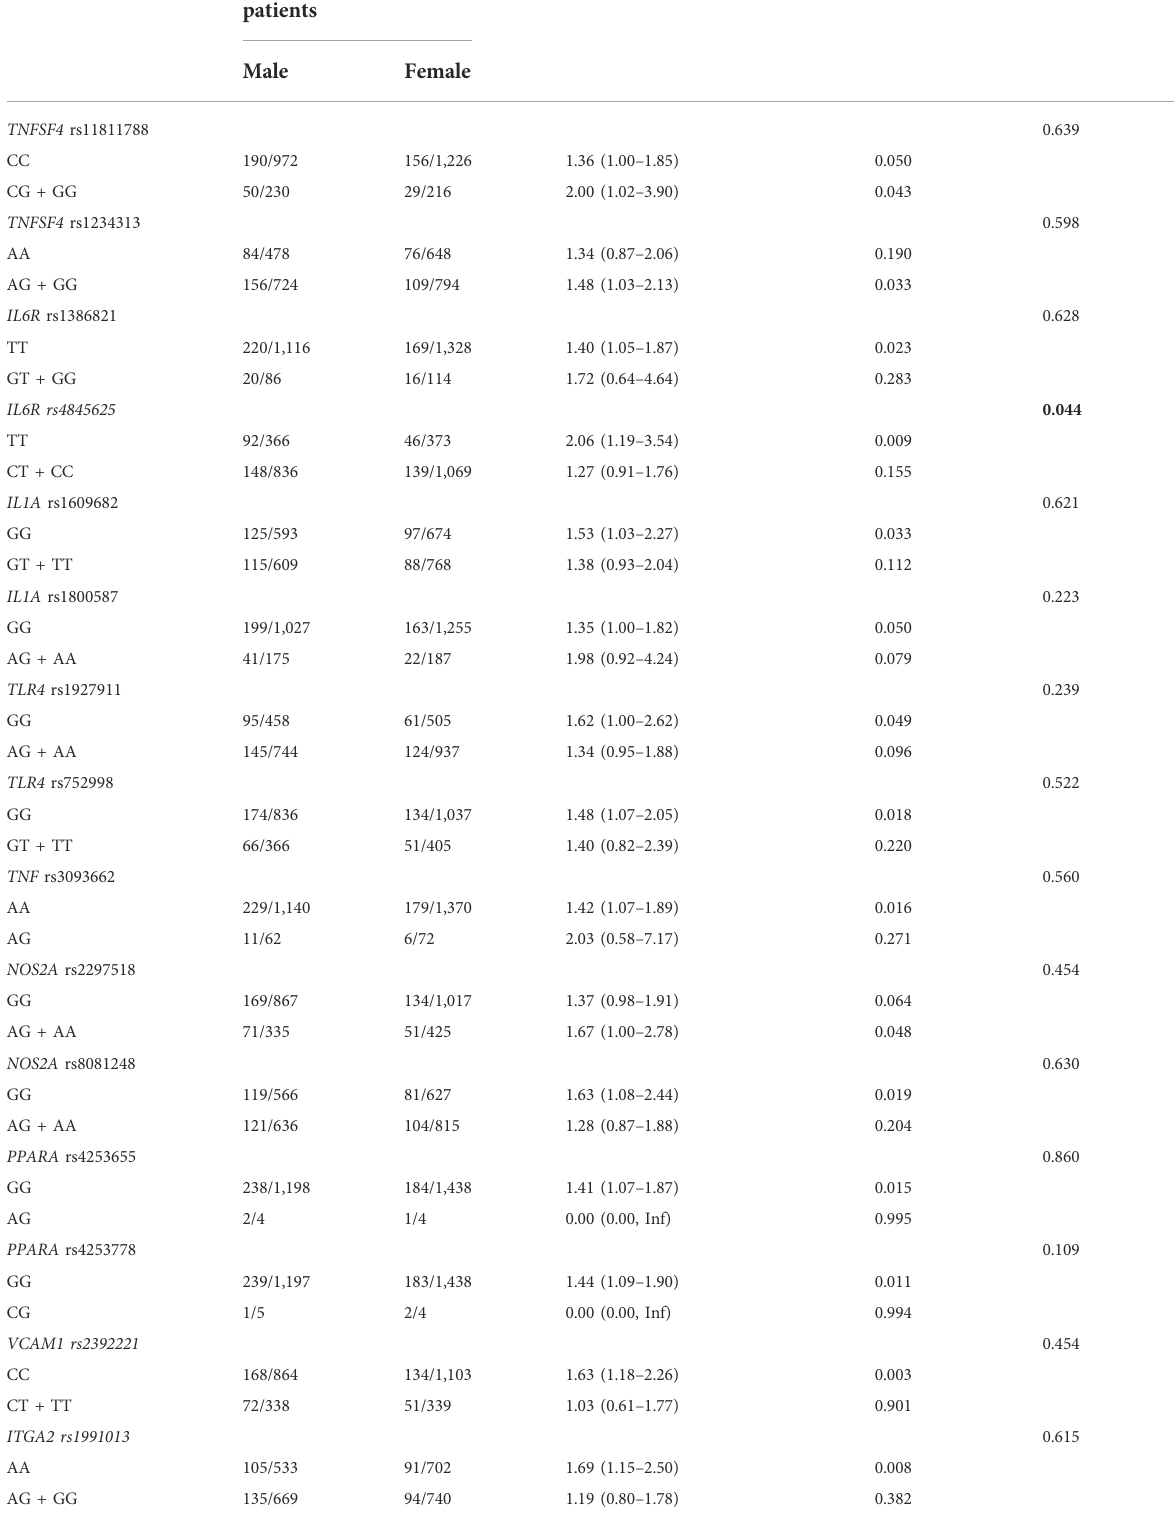
TABLE 4 Interaction tests to identify the SNP that might modify the association between sex and vulnerable carotid